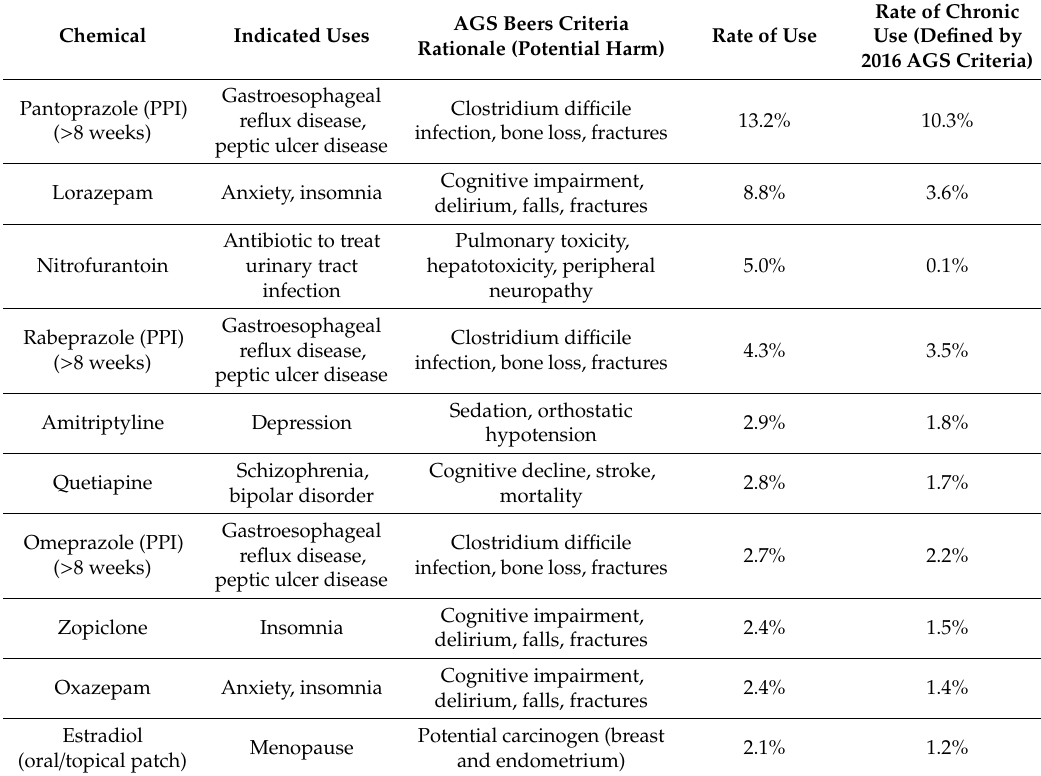
Table 2. Top 10 chemicals from American Geriatric Society Beers list prescribed to seniors, by the rate of use and chronic use, Canada